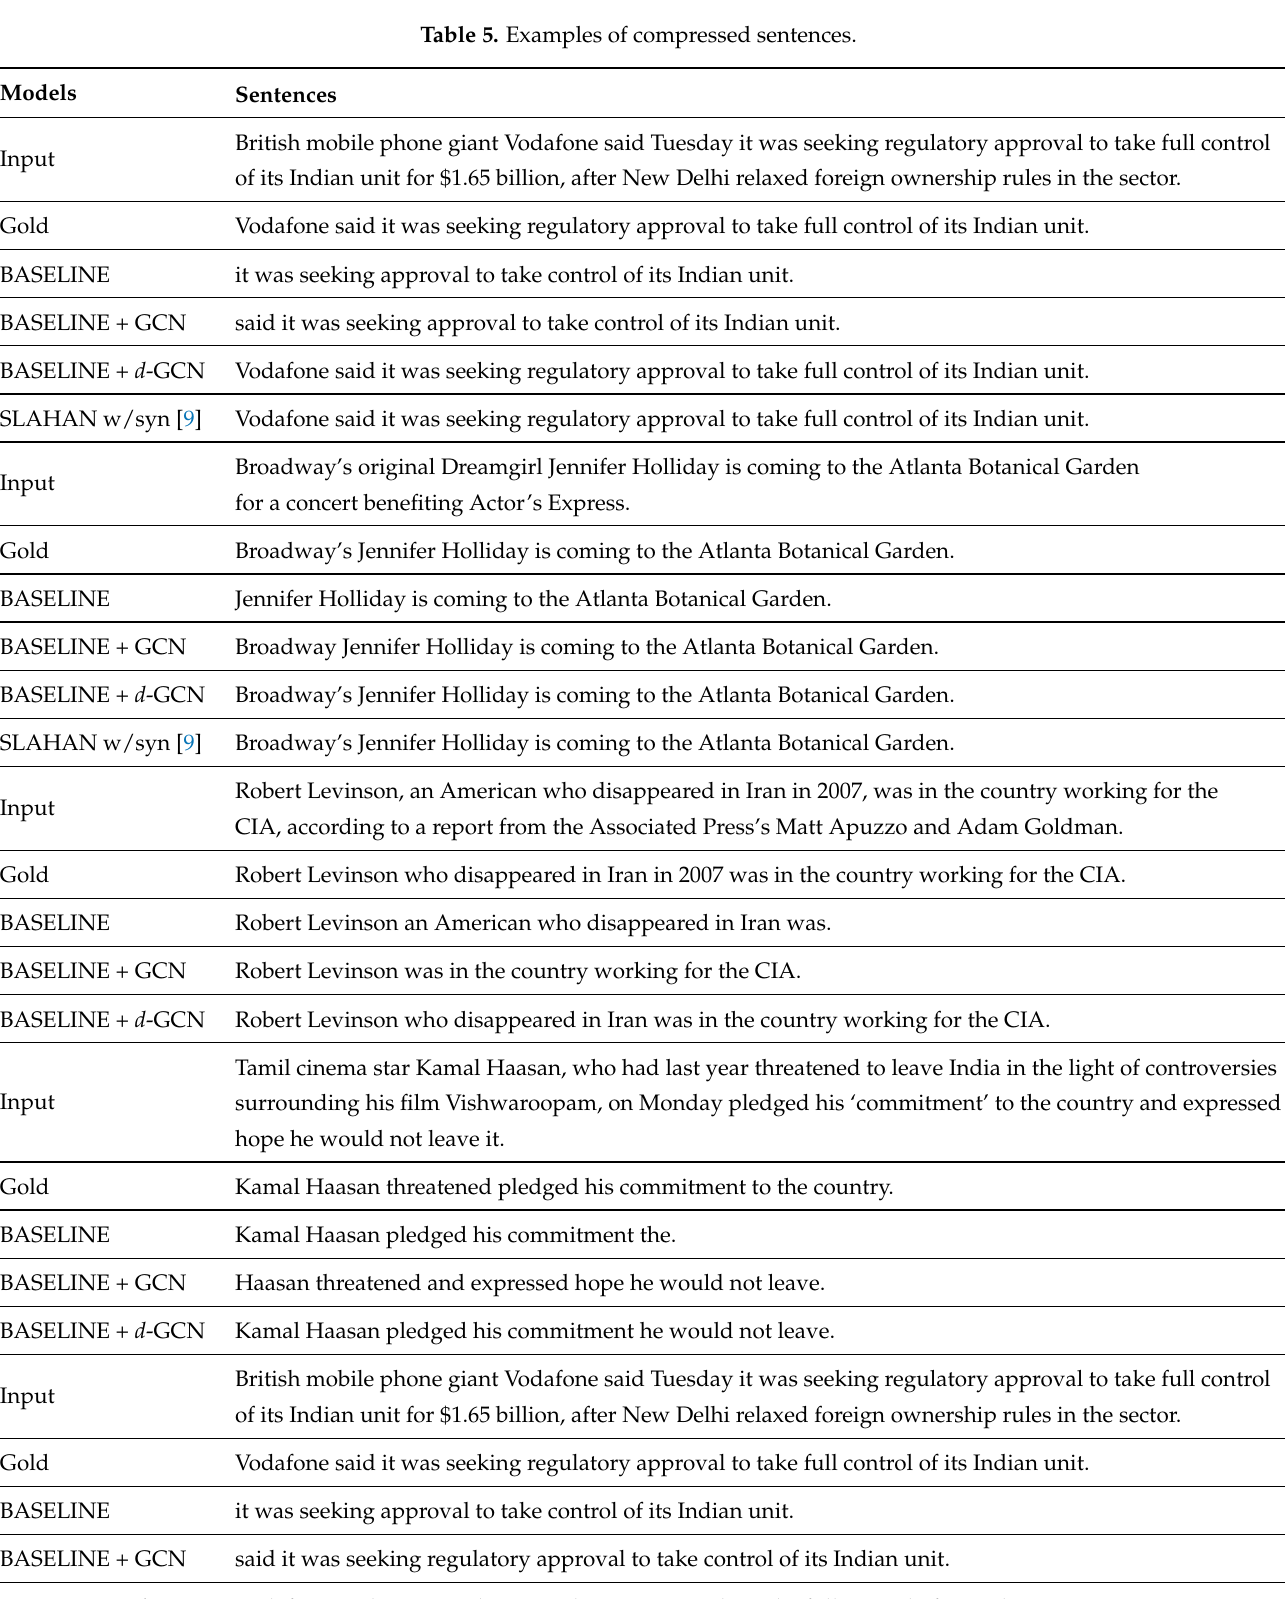
Table 5. Examples of compressed